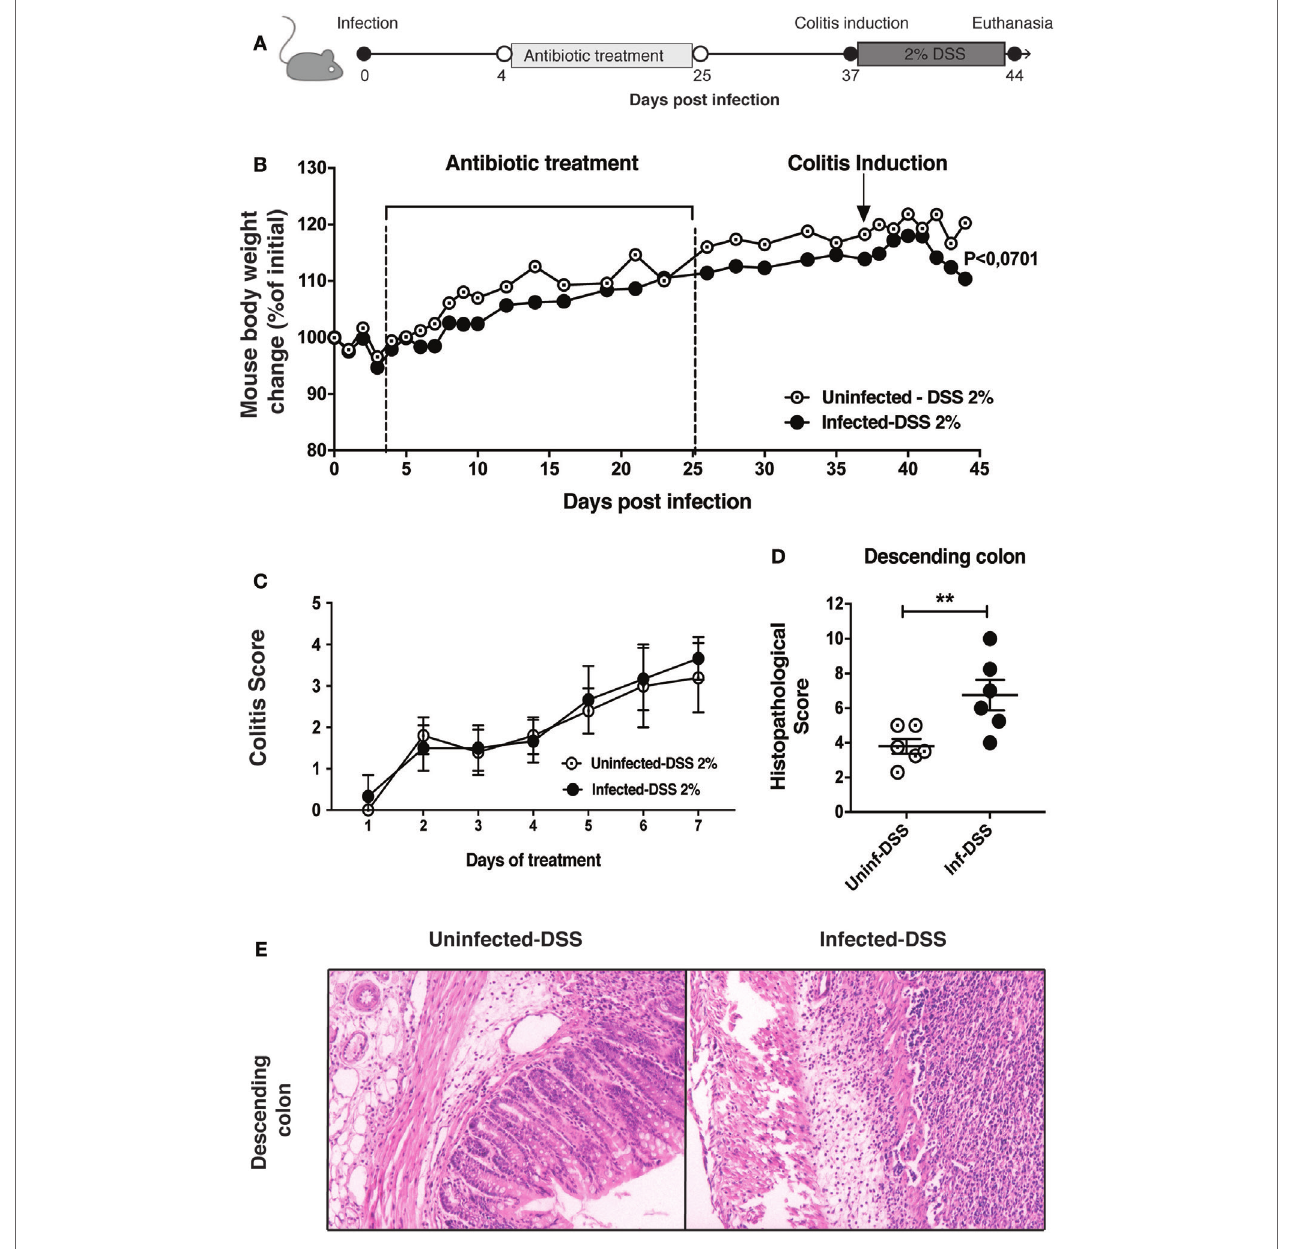
FigUre 1 | Intestinal inflammation due to colitis induction by dextran sulfate sodium (DSS) 2% is increased by previous Salmonella enterica serovar Typhimurium ( S. Typhimurium) infection. (a) C57BL/6 mice were orally infected with 1 × 10 5 CFU of S. Typhimurium wild type (WT). Four days post-infection (days p.i.) mice were orally treated with enrofloxacin (2 mg/ml) for 3 weeks, left untreated for 12 days, and treated orally with DSS 2% for 7 days. (B) Body weight of uninfected and previously infected C57BL/6 mice were recorded on a daily basis for 44 days. (c) Clinical colitis score recorded during the period of colitis induction by DSS 2%, between 37 and 44 days p.i. (D) Average histopathology score of descending colon, performed for three mice per group. (e) Representative images of descending colon at day 44 p.i. between uninfected-DSS and infected-DSS treated mice (4 μ m descending colon section stained with H&E and observed in optical microscope at 10 × magnification). Data shown are mean ± SEM of one experiment with six mice per group. Body weight changes were analyzed using two-way ANOVA with Bonferroni post-test. P < 0.07 between uninfected-DSS 2% and infected-DSS 2% treated mice at 44 days p.i. Histopathology score was analyzed by Mann– Whitney U -test. Data shown are mean ± SEM * P <